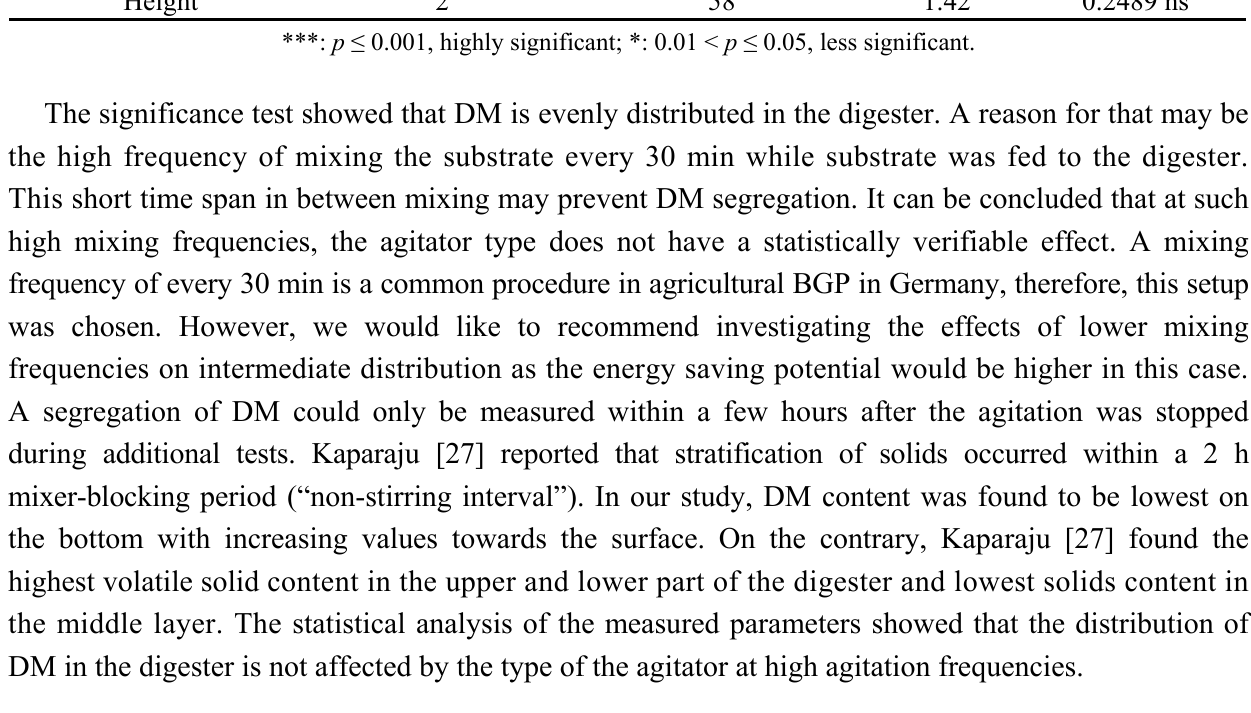
F -Statistic Pr > F